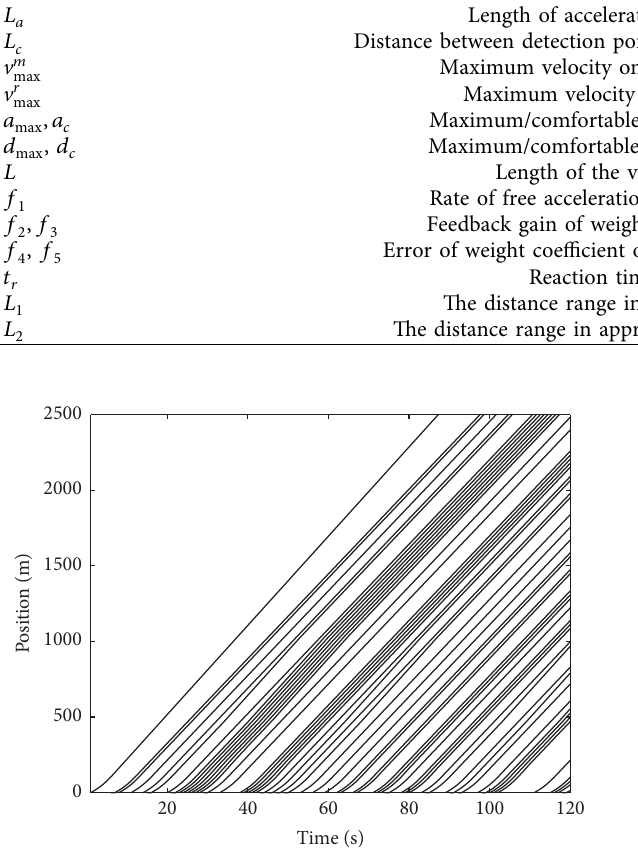
Figure 7: Trajectories with enroute disruption.